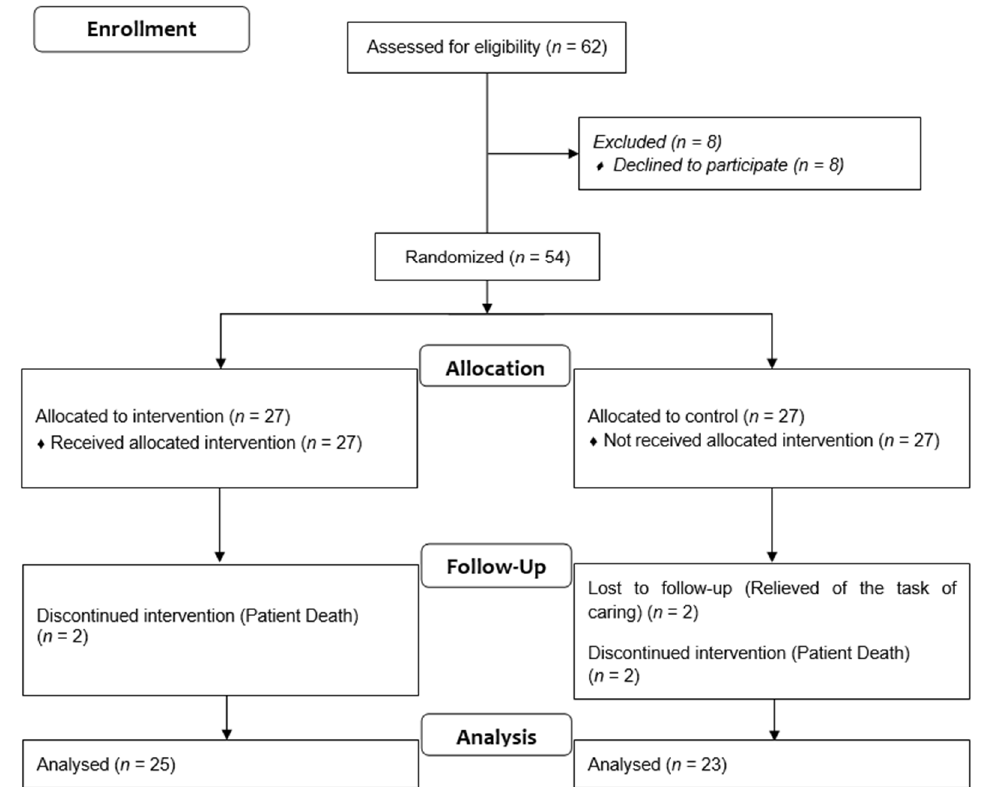
Figure 1. Outline of research process.